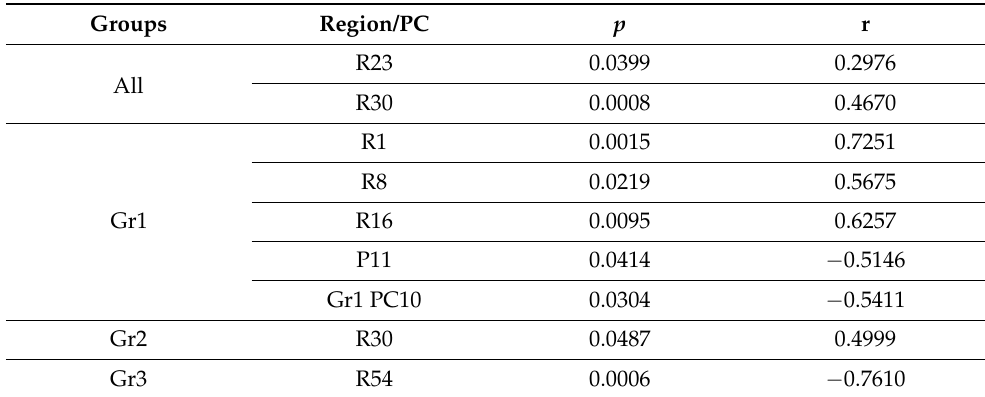
Table A7. Significant linear correlations between spectral peak intensities or principal components and the PSAd. Groups Region/PC p r R9 0.0253 − 0.3227 R50 0.0213 − 0.3317 All PC9 0.0158 − 0.3466 R9 0.0232 − 0.5631 Gr1 Gr1 PC8 0.0195